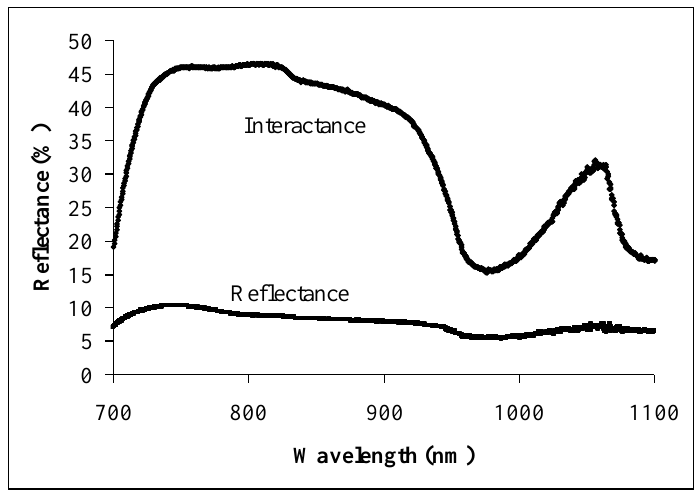
Figure 2. NIR reflectance and interactance spectra of an intact carambola.